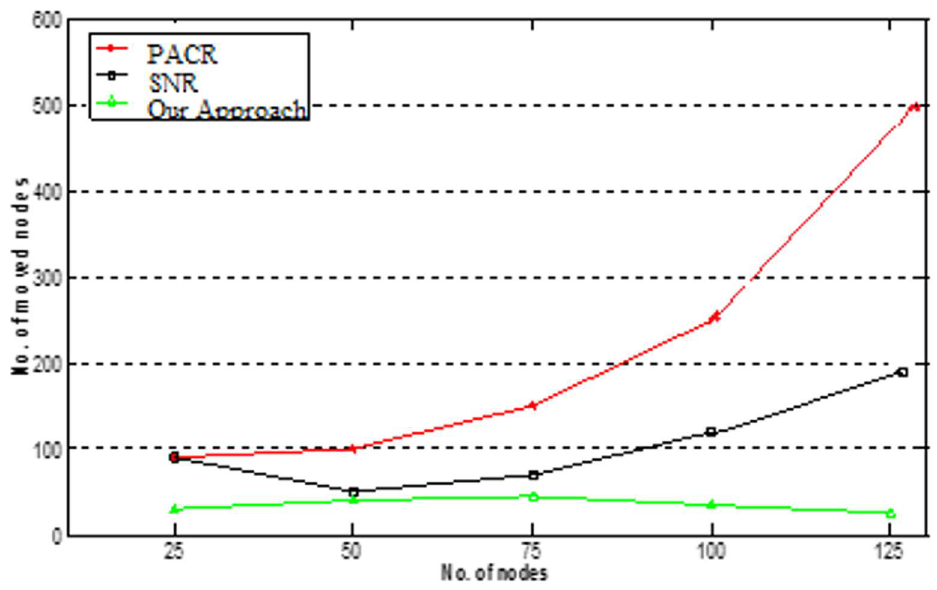
Figure 3. The average number of nodes moved throughout the recovery process.